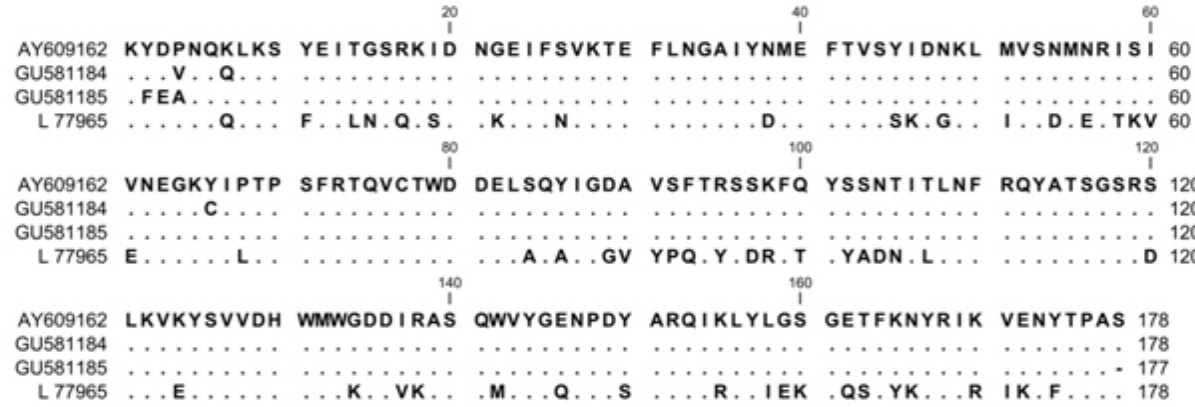
Figure 2. Amino acid alignment of beta2-toxin proteins from two Iranian C. perfringens isolates and the representative strains of consensus (CWC245) and atypical (JGS1604) types. Dots indicate sequences identical to those of the JGS1604 strain.